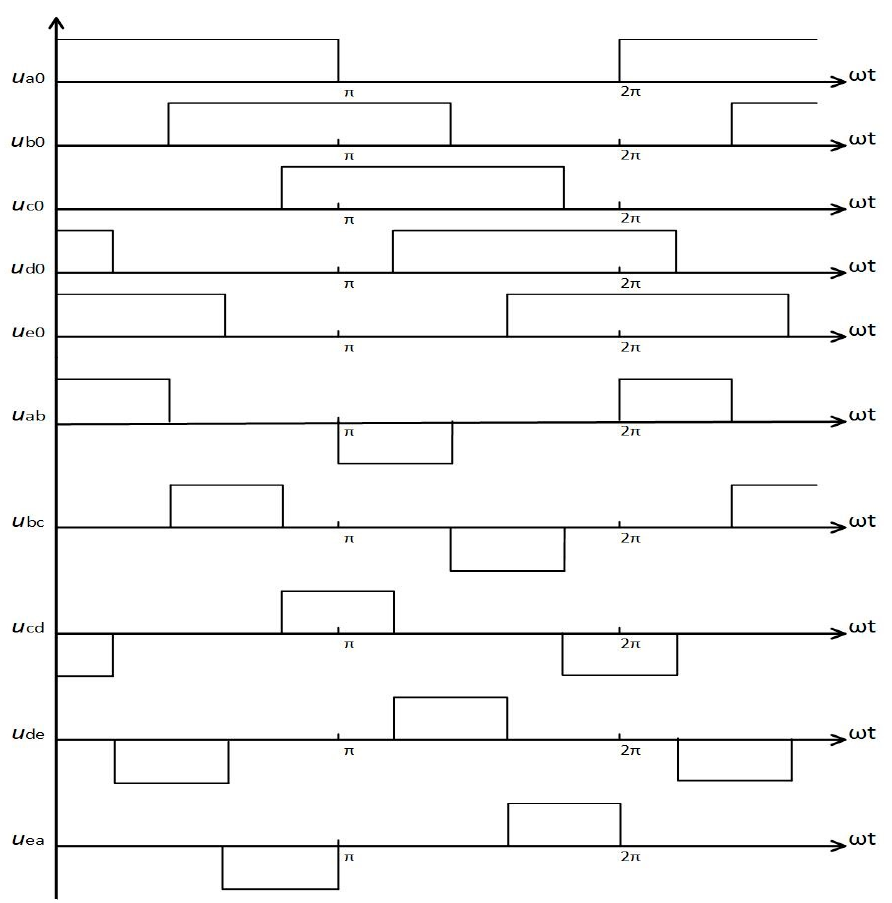
Figure 9. Polar and phase-to-phase voltage waveforms: the pentagon connected load. Vector sequence: V 19 , V 17 , V 25 , V 24 , V 28 , V 12 , V 14 , V 6 , V 7 , V 3 .